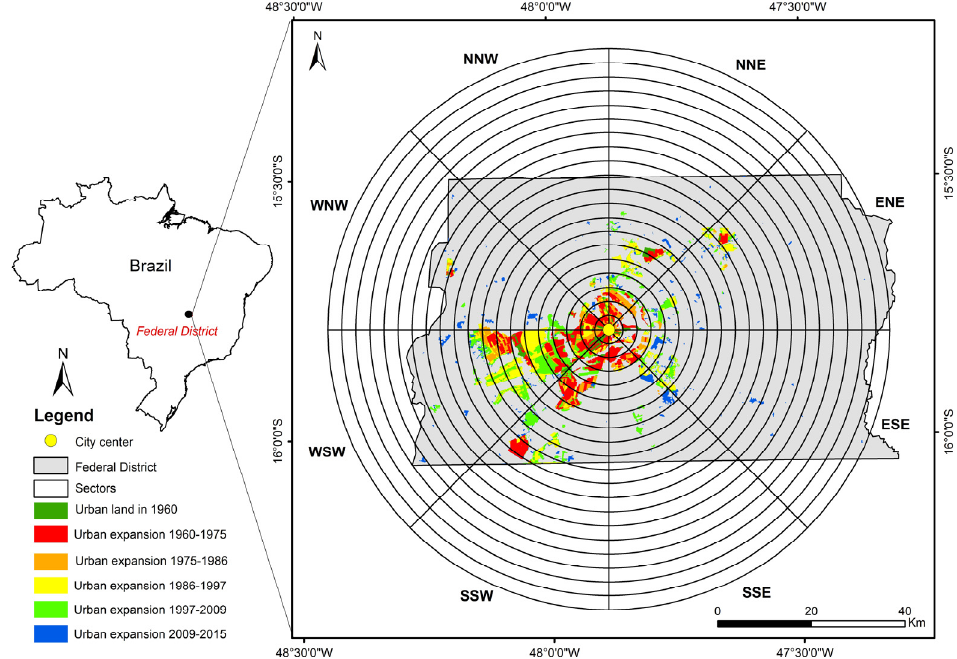
Figure 1. The administrative border (grey polygon) of the FDB, multi-date urban expansion data, and the concentric buffers–geographic directions system.